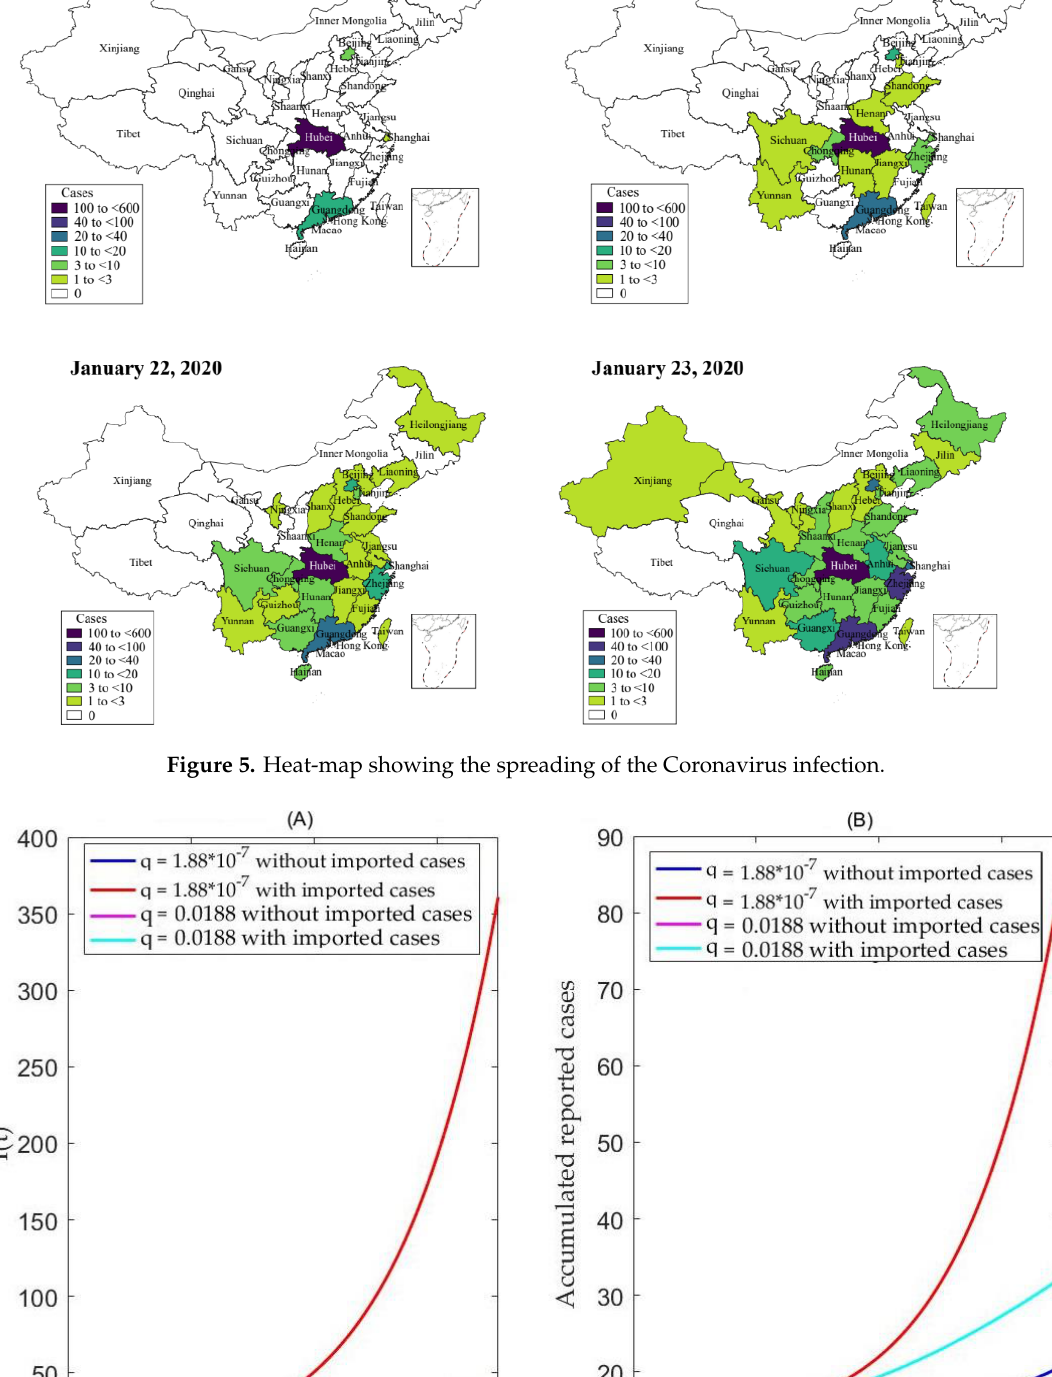
Figure 5. Heat-map showing the spreading of the Coronavirus infection.